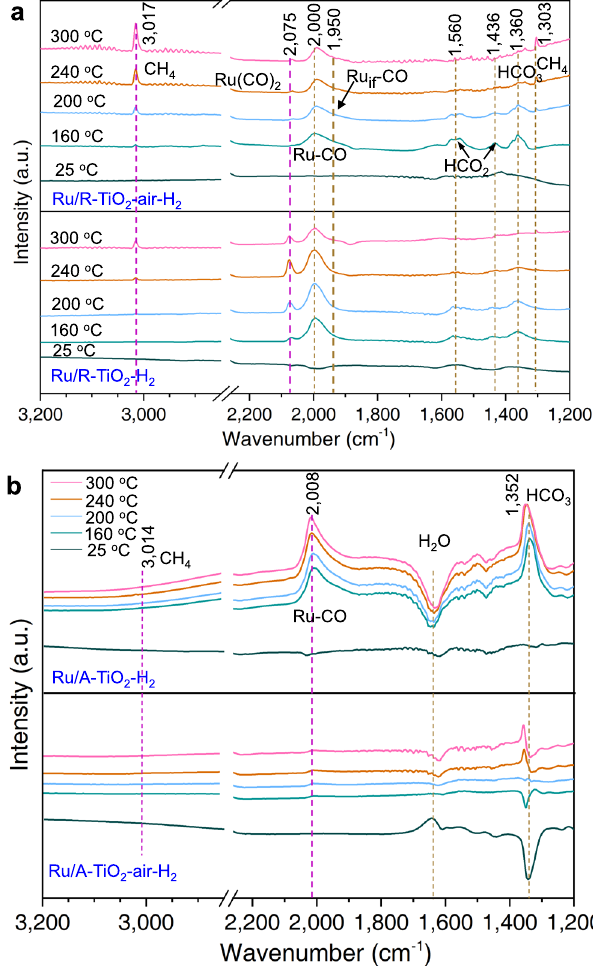
Fig. 5 Revealing reaction mechanisms of CO 2 hydrogenation on Ru/TiO